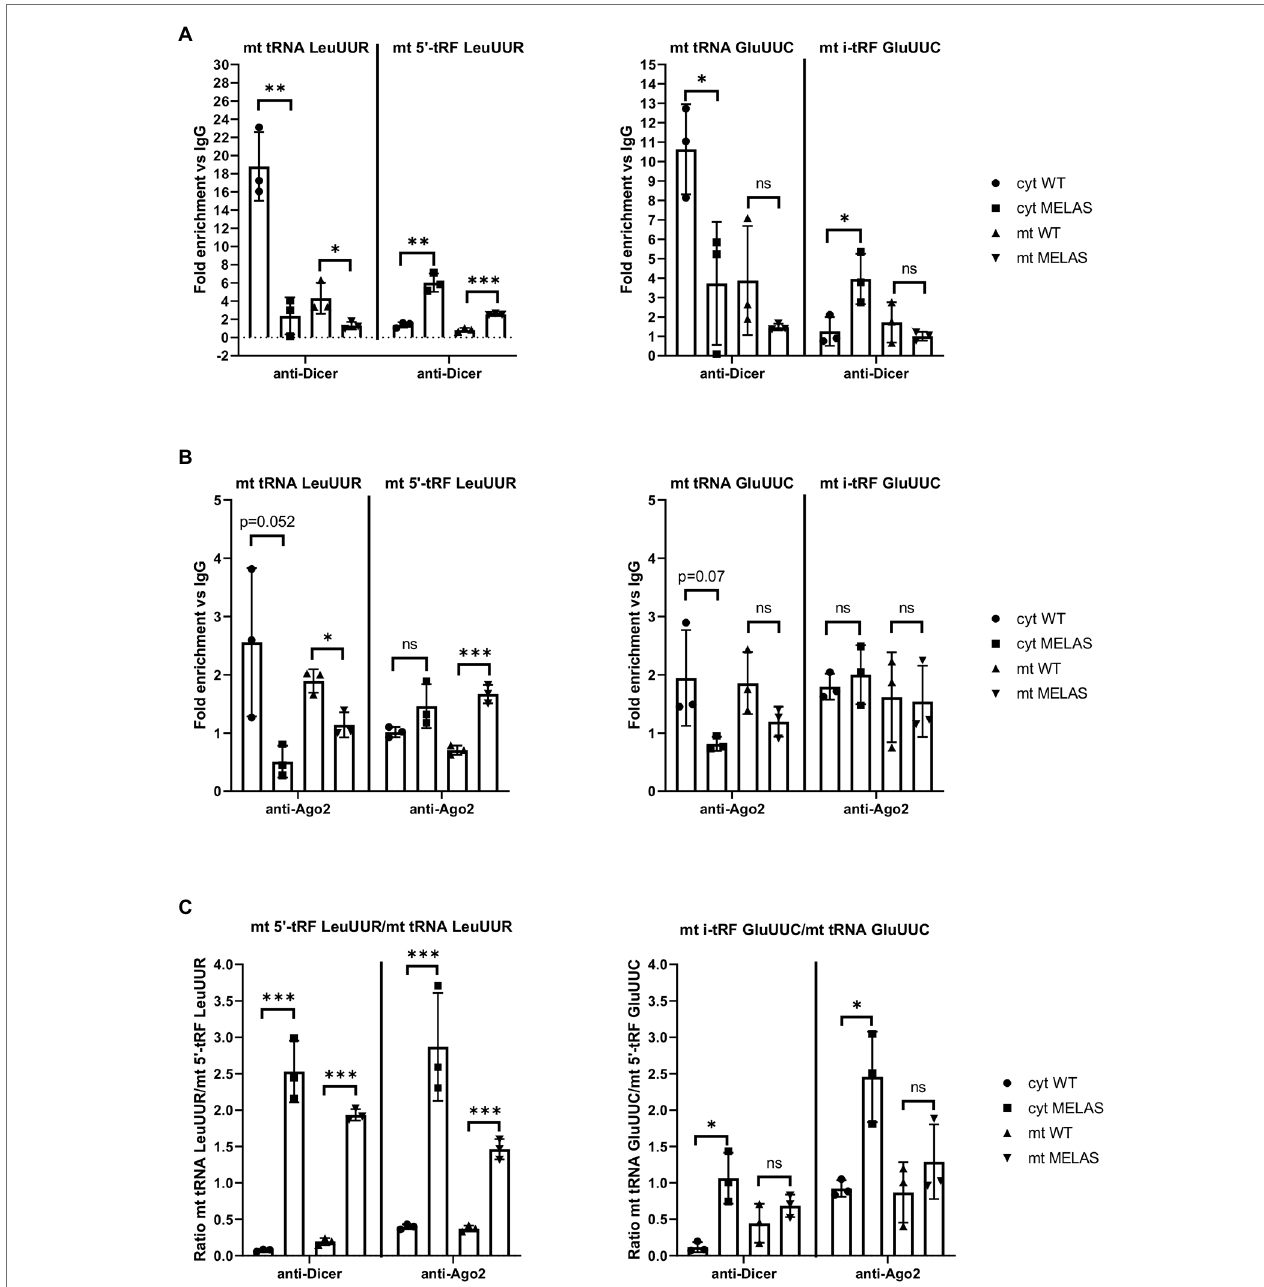
FIGURE 2 | mt tRNAs may recruit Dicer and Ago2. (A and B) RT-qPCR analysis of the expression of mt tRNAs LeuUUR, and GluUUC and mt tRFs, mt 5 ′ -tRF LeuUUR and mt i-tRF GluUUC in Dicer (A) and Ago2 (B) immunoprecipitates from cytosolic and mitochondrial fractions of WT and MELAS cybrids. Data are represented as fold change respect to values from IgG immunoprecipitates. (C) Ratio between fold enrichment values for a mt tRF and its parental mt tRNA in Dicer and Ago2 immunoprecipitates from cytosolic and mitochondrial fractions of WT and MELAS cybrids. Differences from control values were found to be statistically significant at * p < 0.05, ** p < 0.01, *** p <